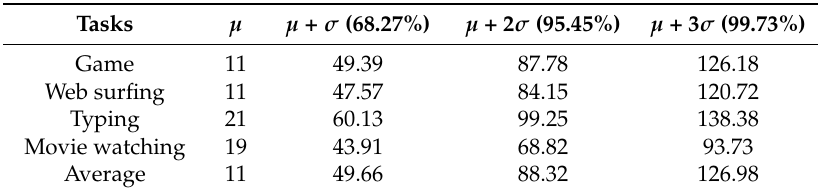
Table 5. The velocities of head movement in successive images through the analysis based on Gaussian fitting (in pixels/s). Tasks